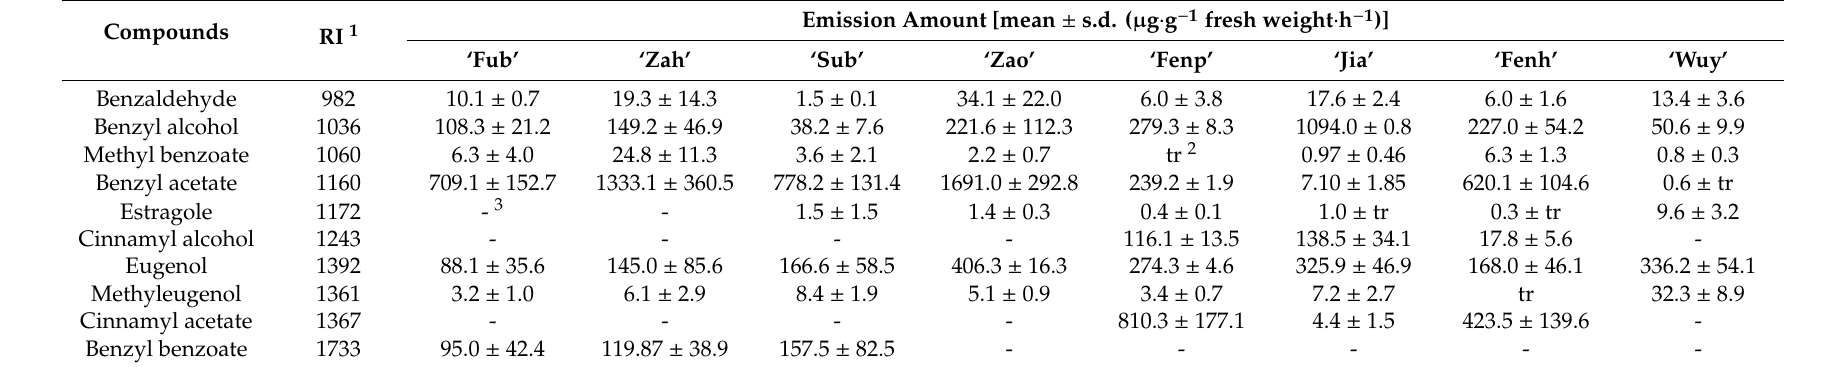
Table 2. Emission amount of main floral scent compounds in the eight P. mume